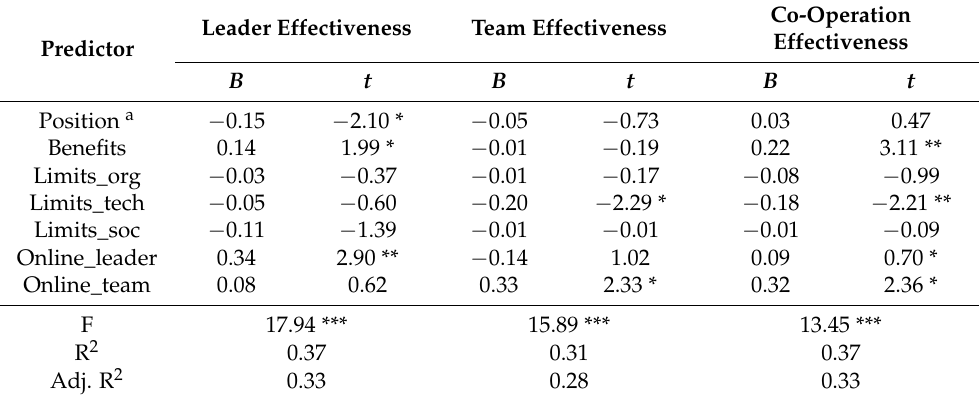
Co-Operation Effectiveness